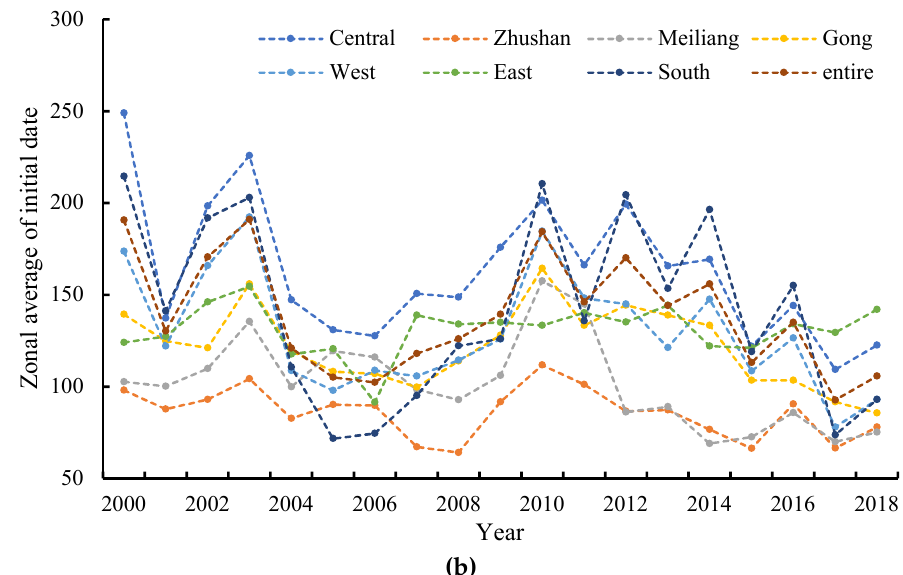
Figure 12. ( a ) Spatial distributions of the annual initial date of cyanobacteria blooms after January; ( b ) zonal average statistics of the annual initial date.